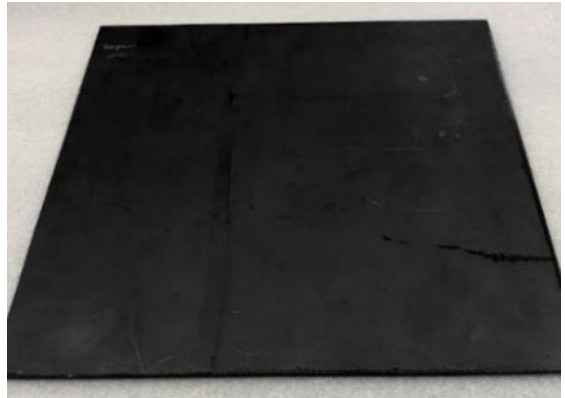
Figure 3. Test panel with Tuball paper (L_TP). Dimensions: 300 mm × 300 mm.